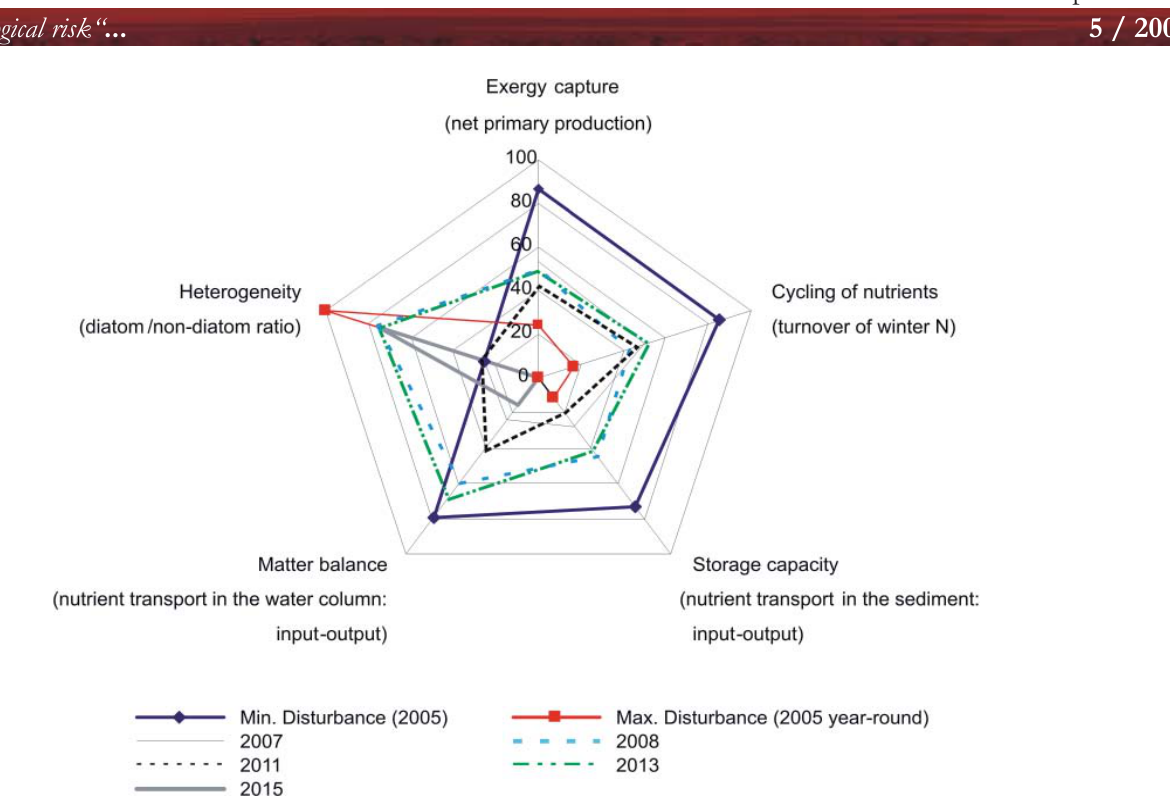
Figure 5. Integrity indicator values for selected years in which offshore wind farm construction takes place in scenario B1 (indicator values are normalised within the value set of both scenarios for offshore wind). Under construction continuing over a 12-month period (maximum disturbance) all indicator values present a decrease if compared with the minimum dis- turbance situation (2005), with the exception of the diatom/non-diatom ratio (heterogeneity, for more detailed explanation see